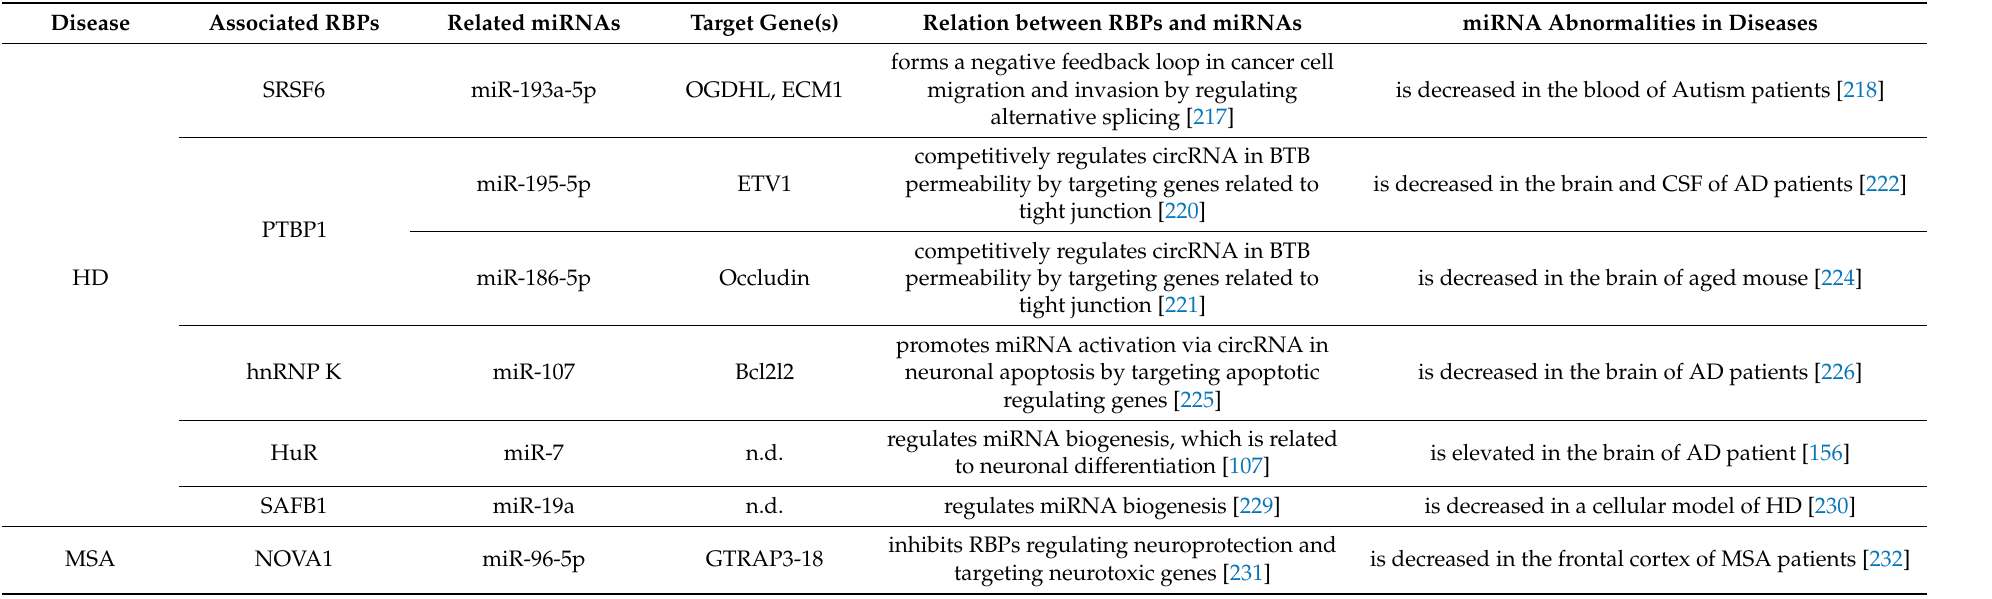
Table 5. List of interactions between the RBPs and miRNAs in HD and